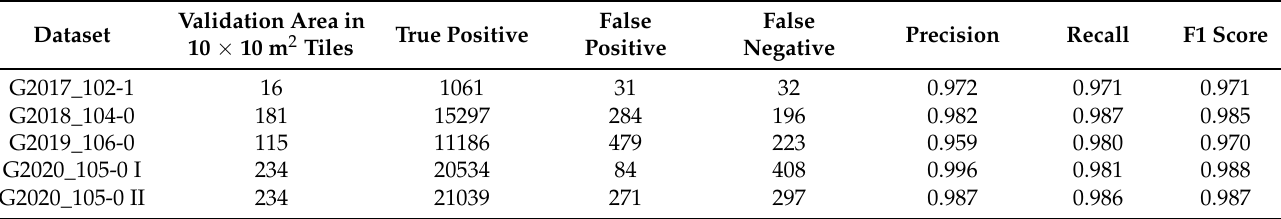
Figure 13. Labeled pumpkin counting errors. False positive in red ( a , c ) and false negative in blue ( b , d ). Table 4. Validation results for all